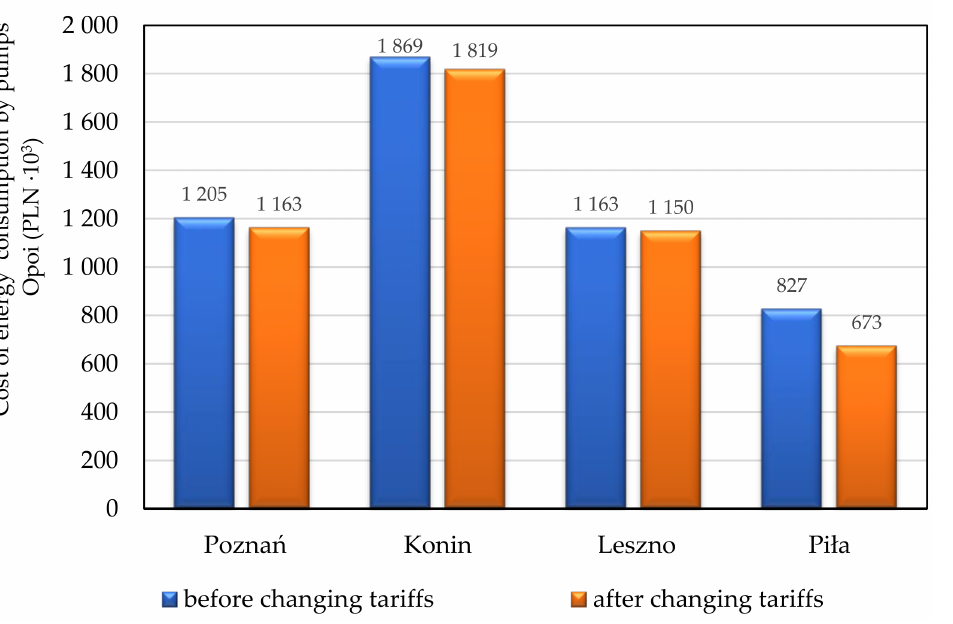
Figure 7. Average yearly cost of pump energy consumption (in PLN~0.22 € ) before and after tariff change, achieved during the four-year research period.